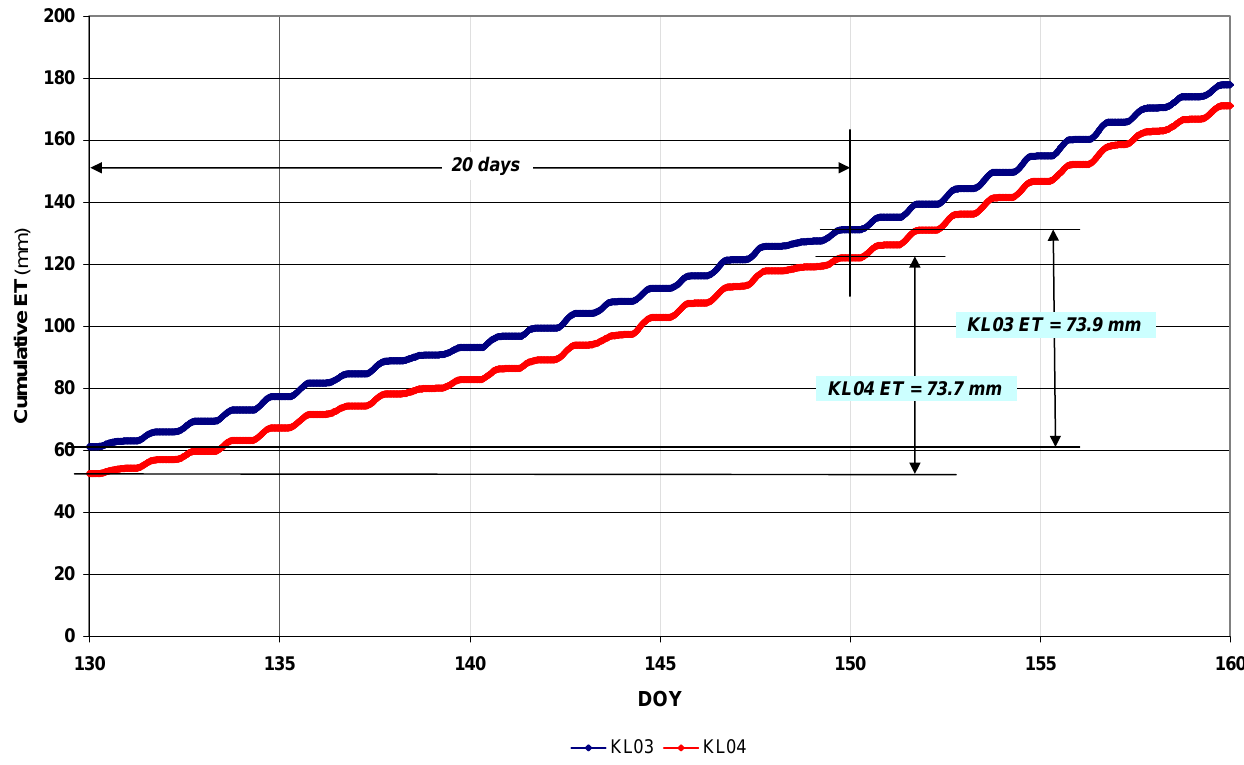
Figure 4. Comparison of Bowen ratio station cumulative latent heat flux for KL03 (unirrigated) and KL04 (irrigated) for 20-day period from DOY 130 through 150,